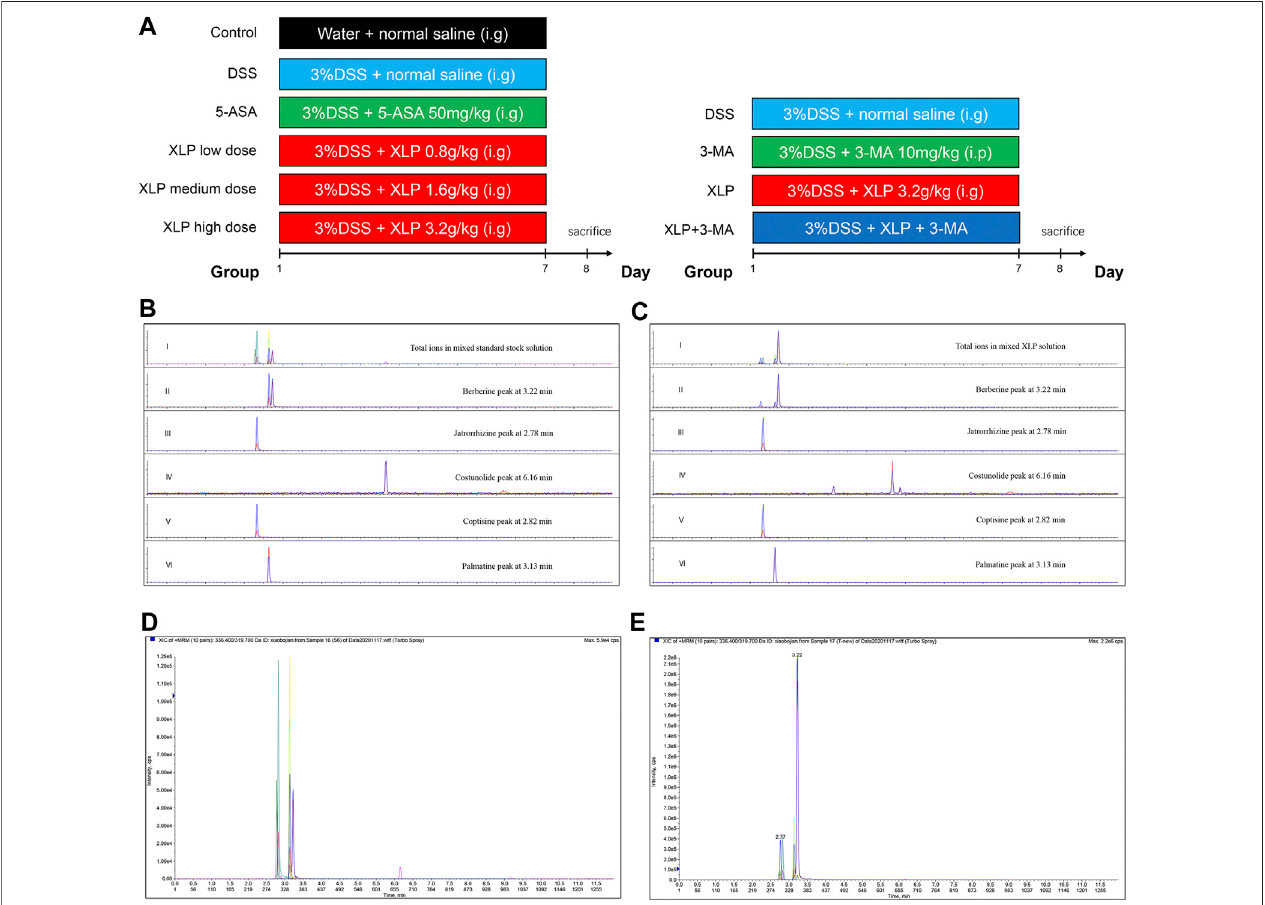
FIGURE 2 | Schematic diagram and analysis of main compounds of Xianglian pill. (A) Experimental design and grouping of the study. (B) Extracted Ion Chromatogramof fi vemainchemicalcomponents inmixed standardstock solution. (C) Extractedlonchromatogram of fi vemain chemical components inXLPsolution. (D) Totallonchromatogramsof fi vemainchemicalcomponentsinmixedstandardstocksolution. (E) Totallonchromatogramsof fi vemainchemicalcomponentsinXLP